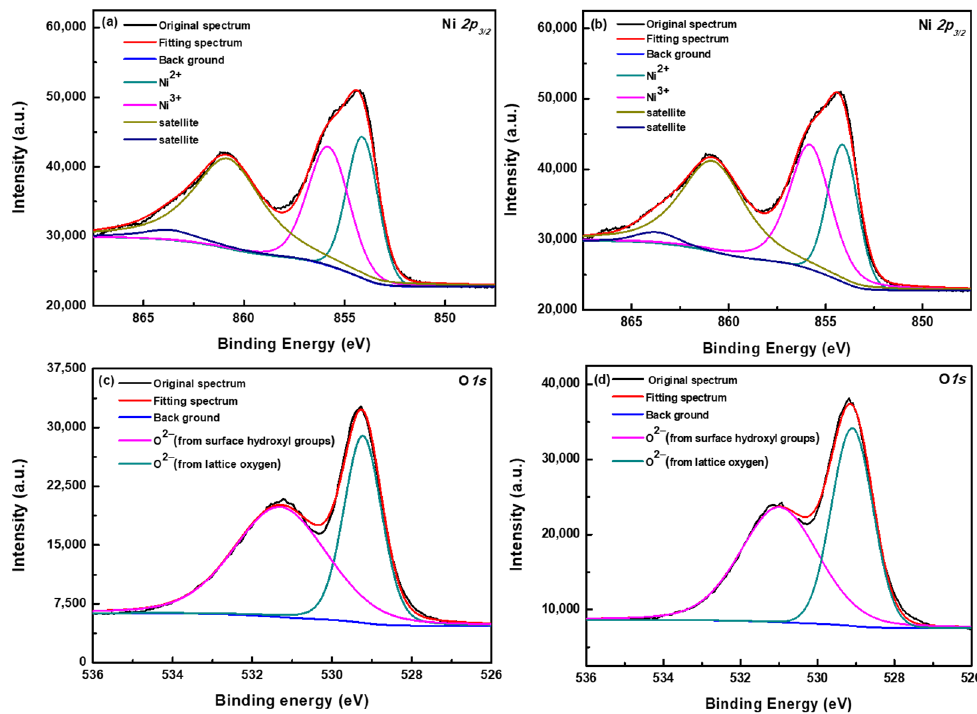
Figure 6. XPS spectra of Ni 2p 3/2 and O 1s elements in the ( a , c ) NiO x thin film and ( b , d )